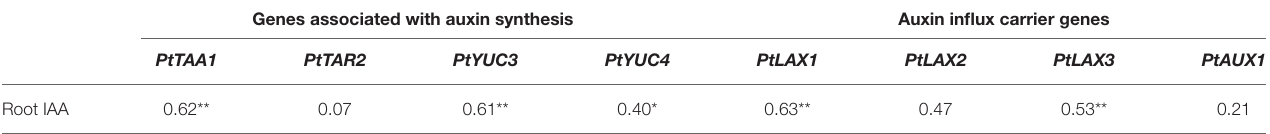
TABLE 4 | The Pearson’s correlation coefficient between root IAA and expressions of auxin synthetase genes and carrier genes ( n = 28). Genes associated with auxin